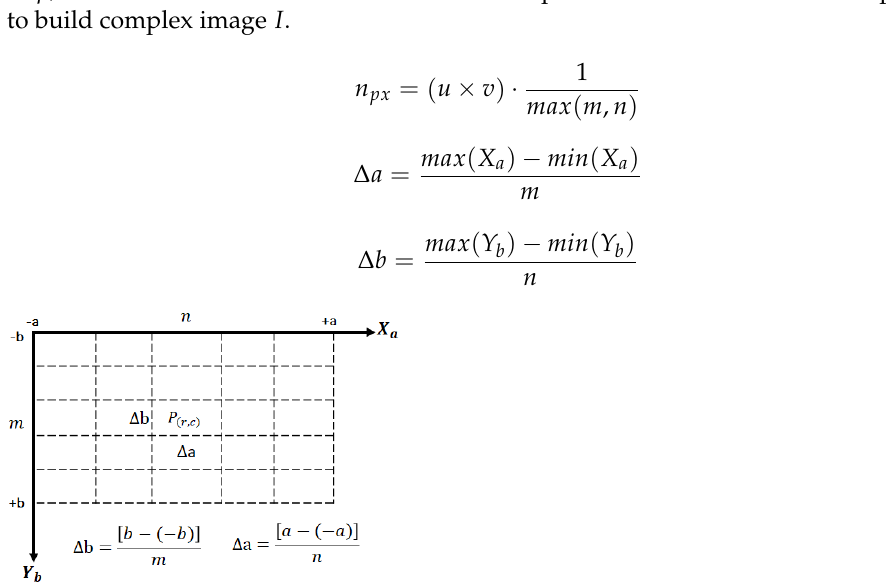
Figure 5. Chromatic map AB divided into m × n blocks on the chromatic range given by ∆ a and ∆ b